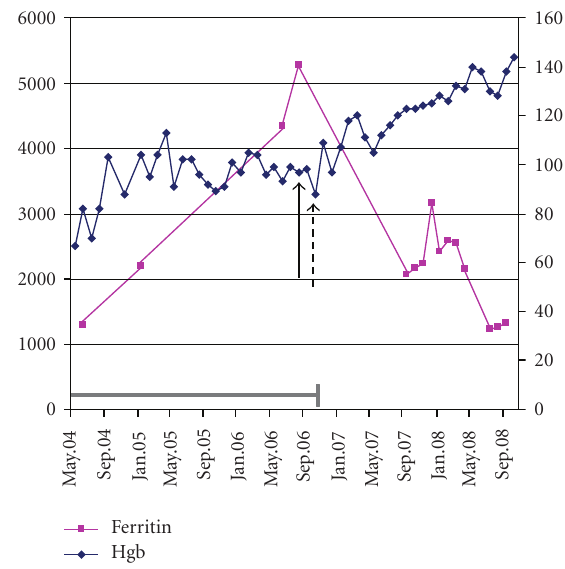
Figure 1: Hemoglobin and serum ferritin levels for a patient with MDS receiving iron chelation therapy. The solid black arrow represents the date at which chelation was initiated and the dashed arrow represents the date of his last red blood cell transfusion. The grey bar indicates the period during which transfusion requirement was 3 red blood cell units every 4